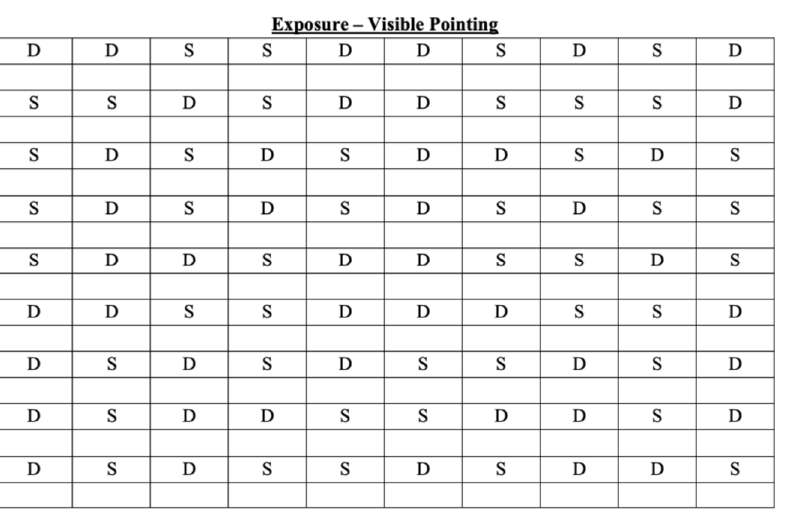
Figure 4. The figure shows how the 90 pointing movements are divided during the exposure phase. S = pointing movement toward the left; D = pointing movement toward the